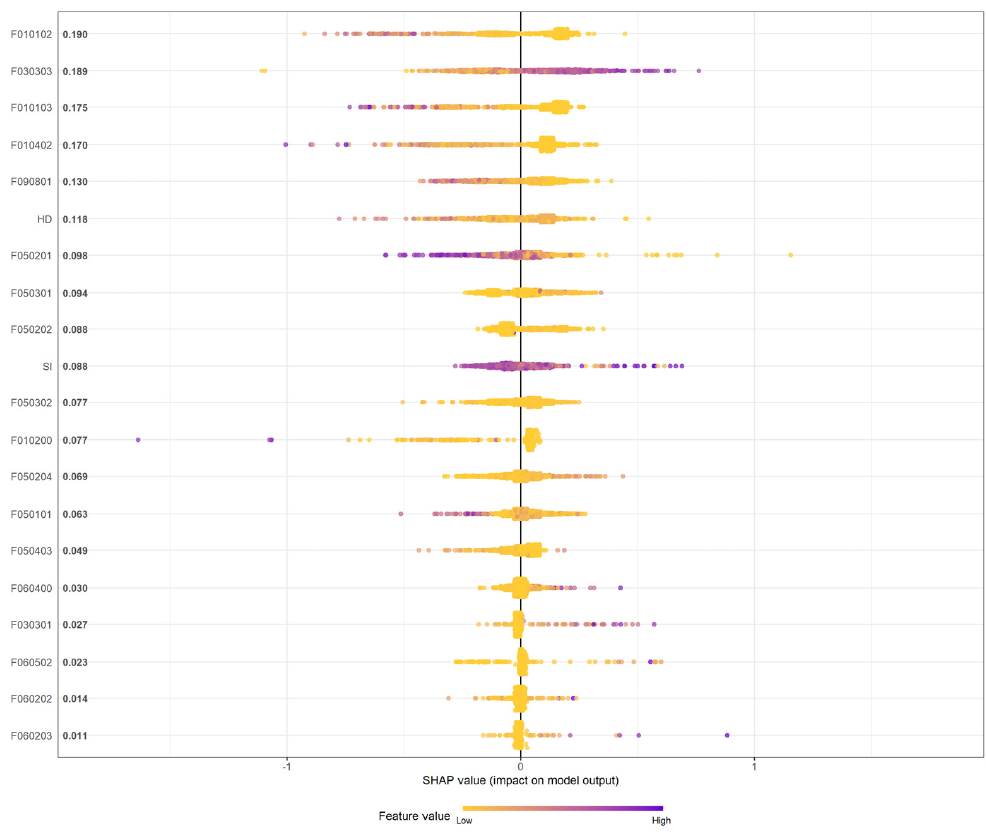
Figure 2. SHAP summary plot. The plot indicated the global variable influences (the relative importance of each variable is ordered) and local explanation (purple color indicates a higher value of corresponding variables and yellow color indicates lower value) on dengue incidence. SHAP, Shapely Additive Explanations. Table 1. Descriptive statistics of the ten most in fl uential land-use land-cover types from the SHAP summary.